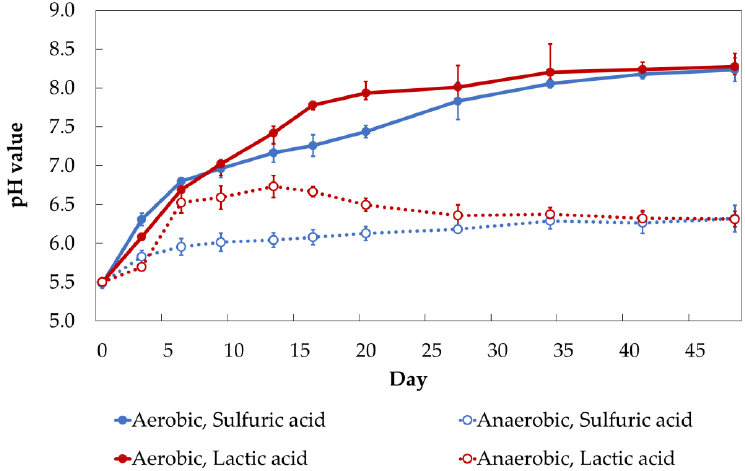
Figure 3. The pH value of dairy cow slurry after acidification with sulfuric or lactic acid to pH 5.5 under aerobic or anaerobic storing conditions during the storage period of 48 days (means ± SD, n = 3).